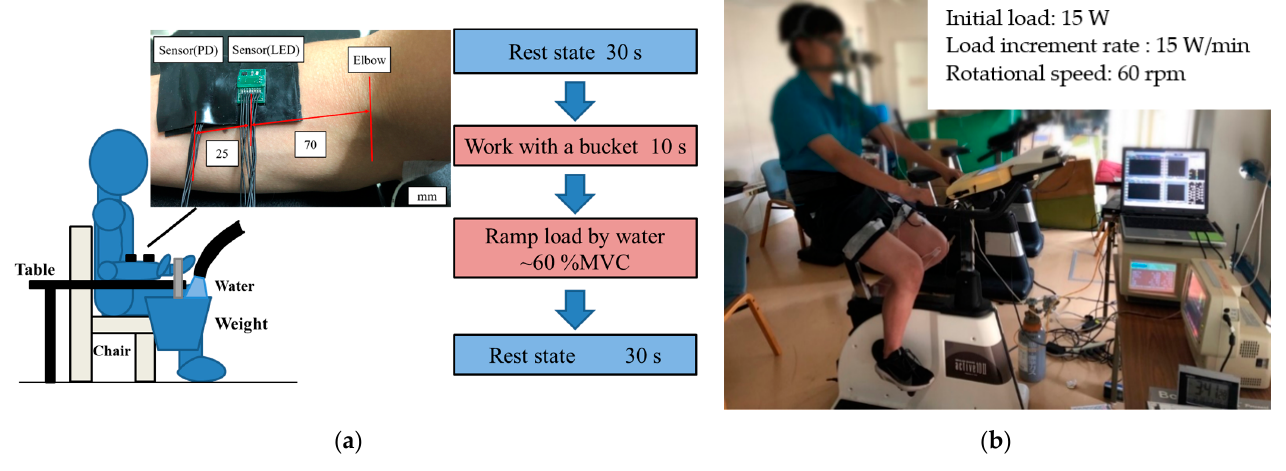
Figure 4. Schematic diagram of the experimental method: ( a ) isometric ramp contraction at the forearm and ( b ) cycling exercise of the lateral vastus muscle with step increments of the load.